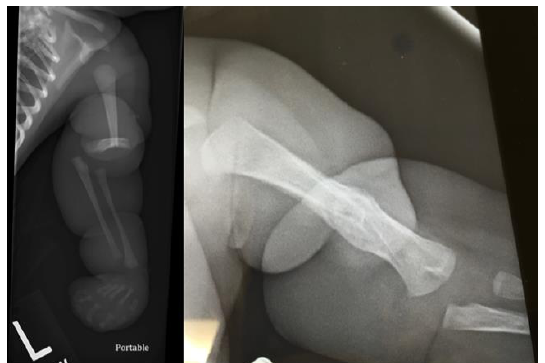
Figure 1. Radiographs of Patient 1: preoperative and 1-year postoperative with healed fracture (left to right).